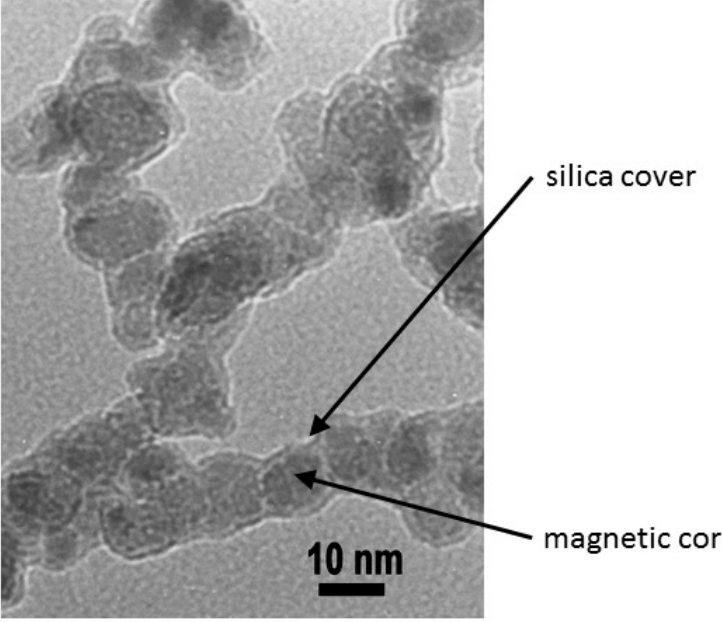
Figure 7. TEM image of superparamagnetic maghemite nanoparticles ( (cid:13) (cid:0) Fe with 20 nm thick